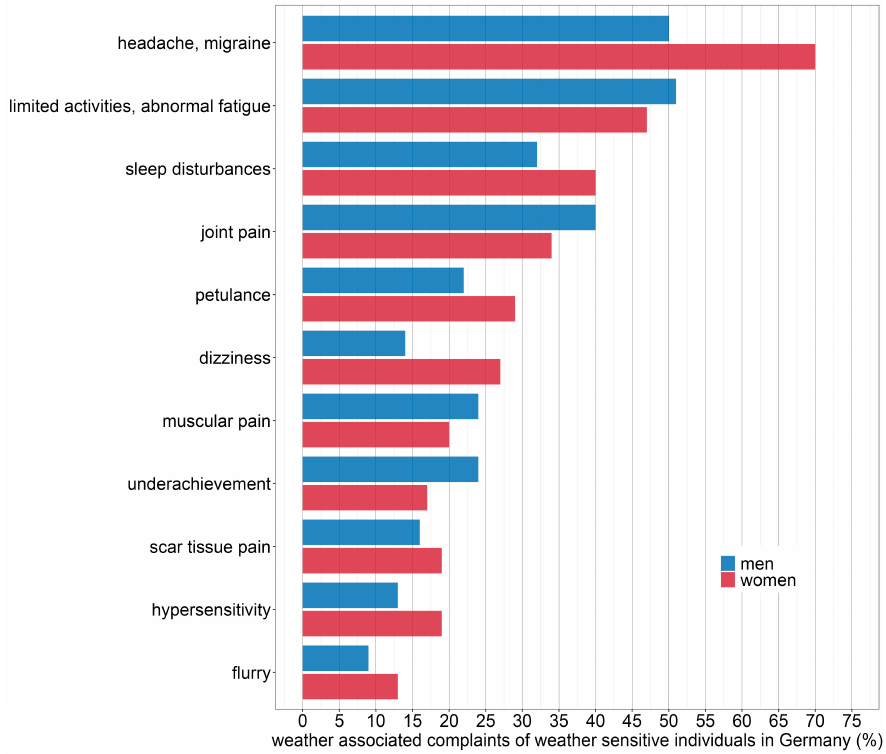
Figure A2. Different frequencies of weather-associated complaints and symptoms among weather- sensitive women and weather-sensitive men.